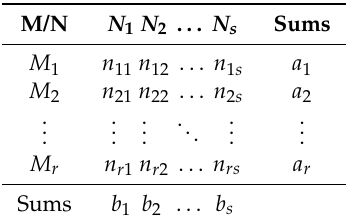
Table 2. Contingency